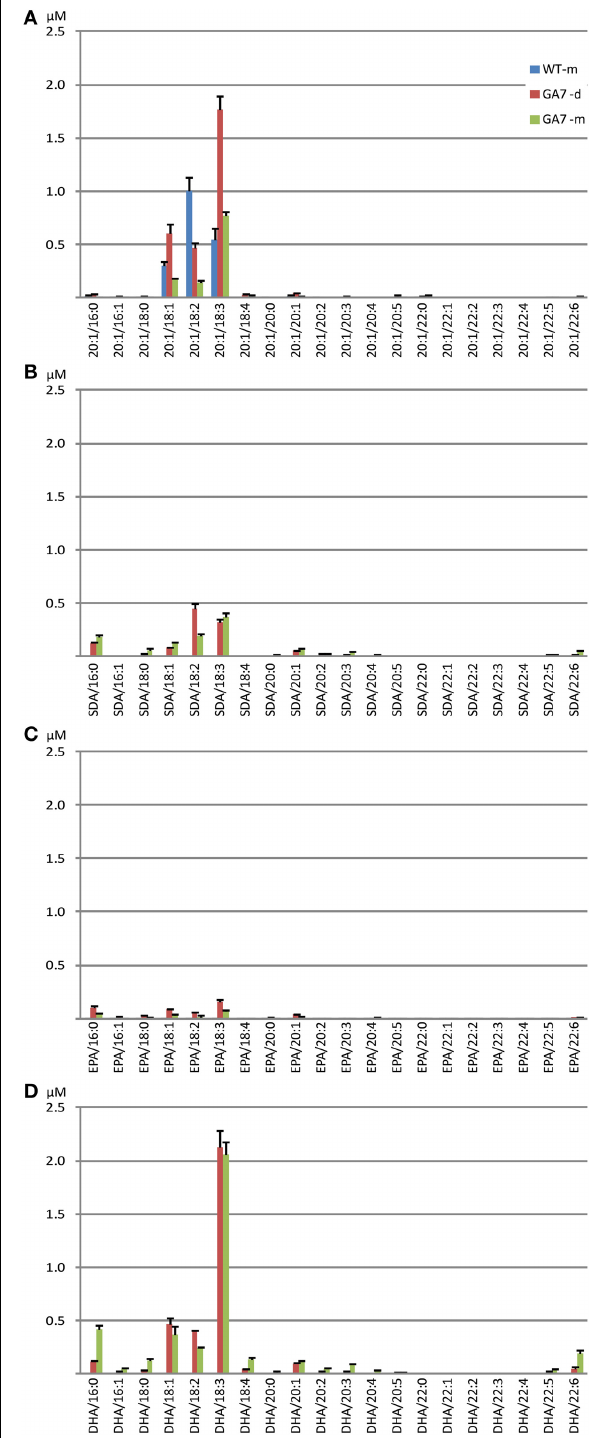
FIGURE 6 | Abundance of different diacylglycerol (DAG) species in the WT and the GA7 Arabidopsis seeds. DAG species are labeled in format of DAG target/X:Y, where target will be 20:1 (A) , SDA (B) , EPA (C) or DHA (D) , with another acyl containing X number of carbons and Y number of double bonds. Data are shown as the mean of triplicate analysis with the error bars representing the standard